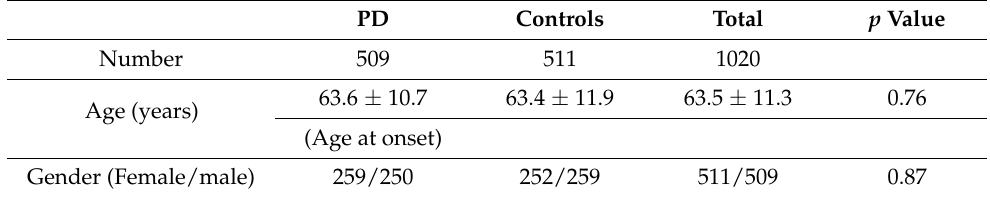
Table 1. Demographic and clinical characteristics of Parkinson’s disease (PD) patients and